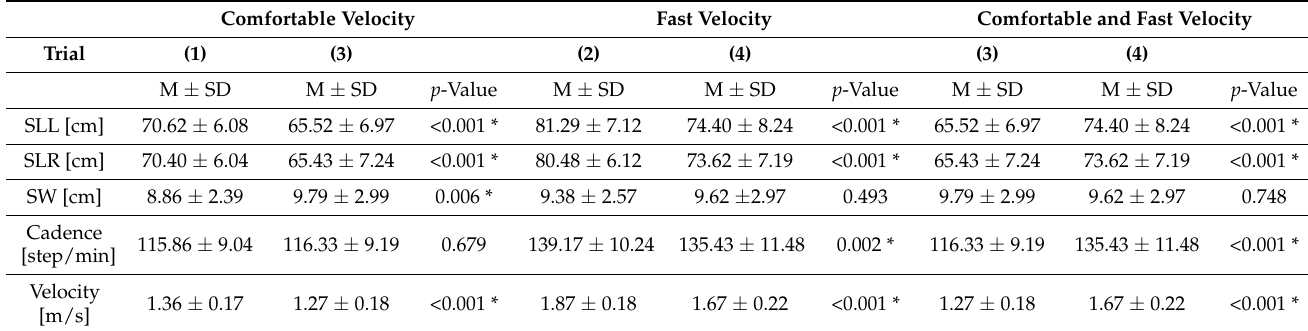
Table 2. Statistical significance of the differences obtained between the analyzed parameters in (2)—walking without a phone with fast velocity. Trial (3)—walking with the phone with comfortable velocity. Trial (4)—walking with the phone with fast velocity. SLL [cm]—step length left,